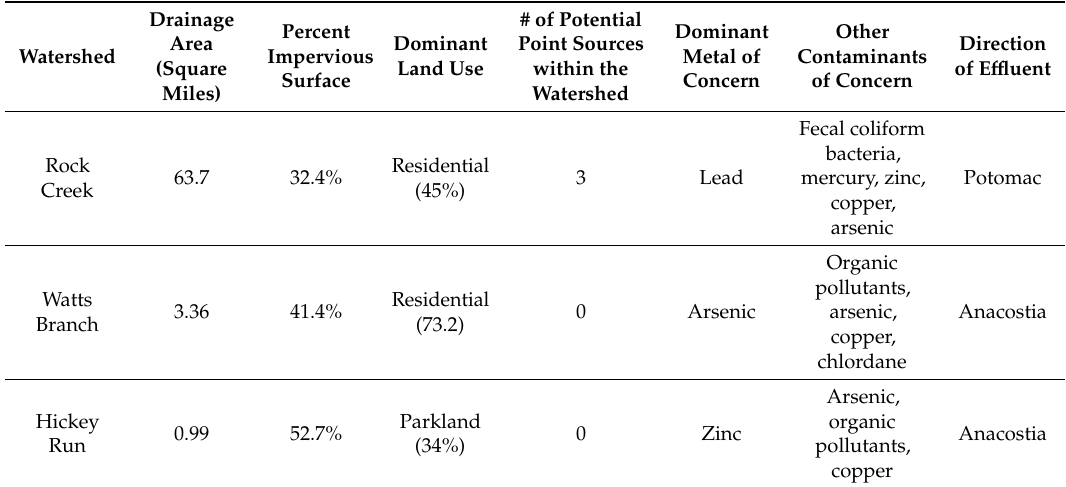
Table 1. Watershed characteristics table for the Rock Creek, Hickey Run and Watts Branch